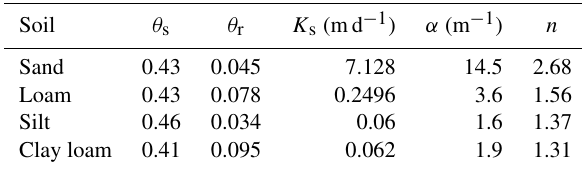
Table 1. Soil hydraulic parameters used in